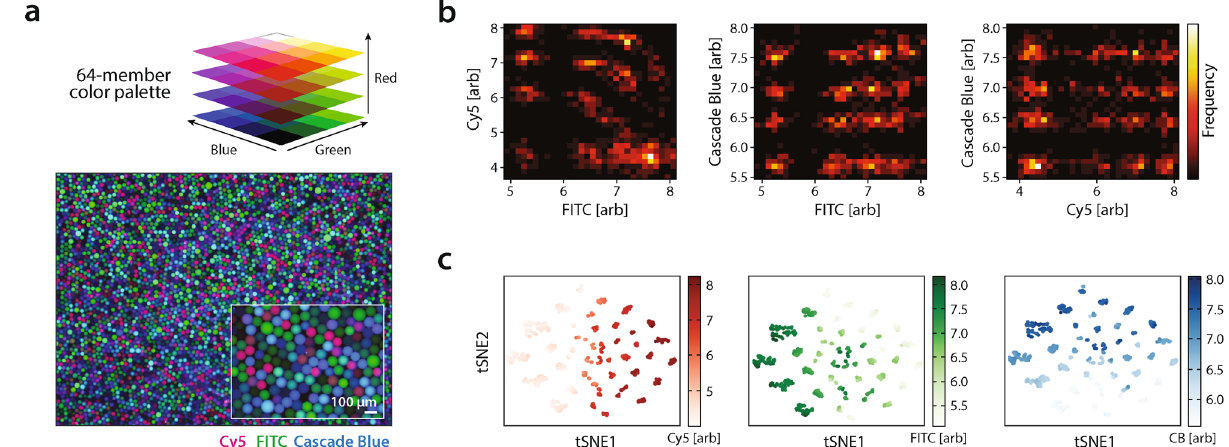
Figure 3. Emulsification of a large optically encoded library. ( a ) A 64-member color palette of all possible combinations of 4 levels of blue, green, and red dyes is emulsified with the printer. ( b ) Based on images of the emulsion, brightness in the Cascade Blue (CB), FITC, and Cy5 channels is extracted from each droplet and visualized as a series of 2-D heatmaps. ( c ) To identify distinct droplet populations, drops are filtered and analyzed by T-distributed stochastic neighbor embedding (tSNE). The raw fluorescence data is overlaid on each analyzed droplet on the tSNE